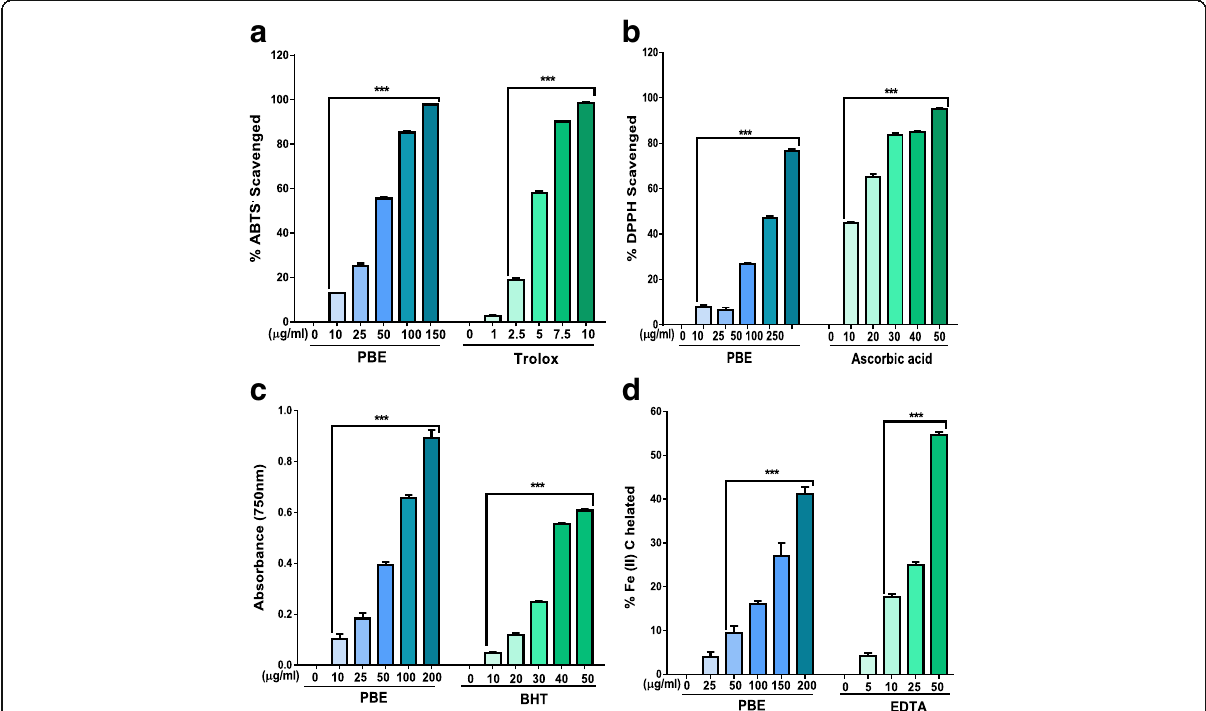
Fig. 1 ABTS ( a ), DPPH ( b ) radicals scavenging, reducing property ( c ) and Fe(II)-chelating potential ( d ) of P. biglobosa leaf extract. Results are mean ± SEM of three parallel measurements. P value: *** P < 0.001 vs 0 μ g/ml. PBE = Parkia biglobosa leaf aqueous-methanol extract; BHT = butylated hydroxytoluene; EDTA = ethylenediaminetetraacetic